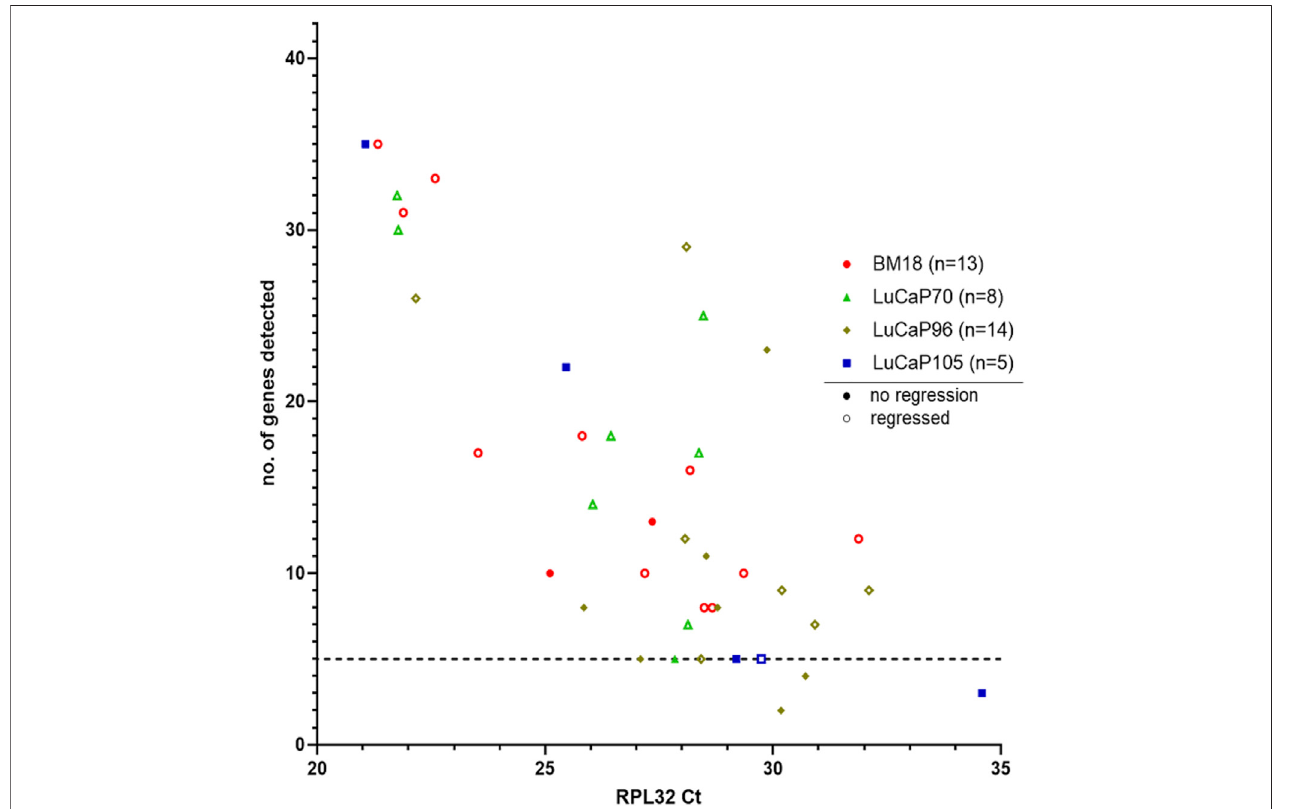
FIGURE 4 | Human-speci fi c RT-qPCR analysis of PDX-bearing mouse blood samples. Scatter plot for RPL32 raw Ct value against number of genes detected (maximum = 42), where each symbol corresponds to an individual mouse. Low Ct values correspond to higher gene expression. A correlation was observed between number of genes detected and RPL32 expression ( p = 0.0000075, r = − 0.63). Samples that had less than fi ve genes detected (1 LuCaP105 and 2 LuCaP96) were excluded from further analysis.